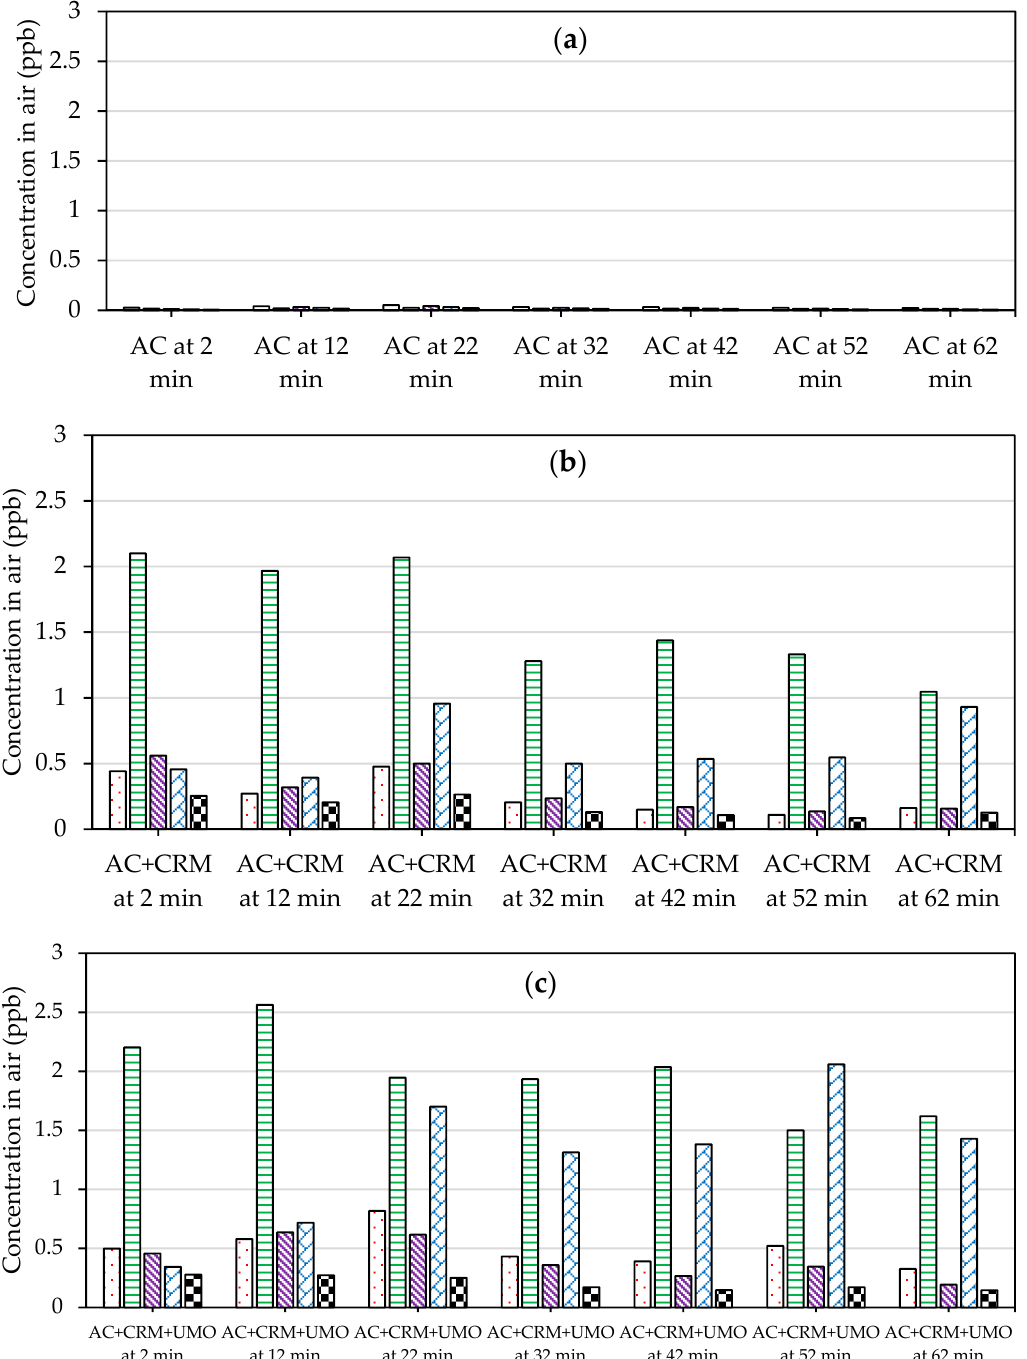
Figure 18. BTEX in air above PG 52-28 neat and modified asphalt binder samples interacted at 170 °C—50 Hz and different interaction times; these samples were ( a ) neat asphalt binder (AC); ( b ) AC + 15% CRM; ( c ) AC + 15% CRM + 2.5% UMO.